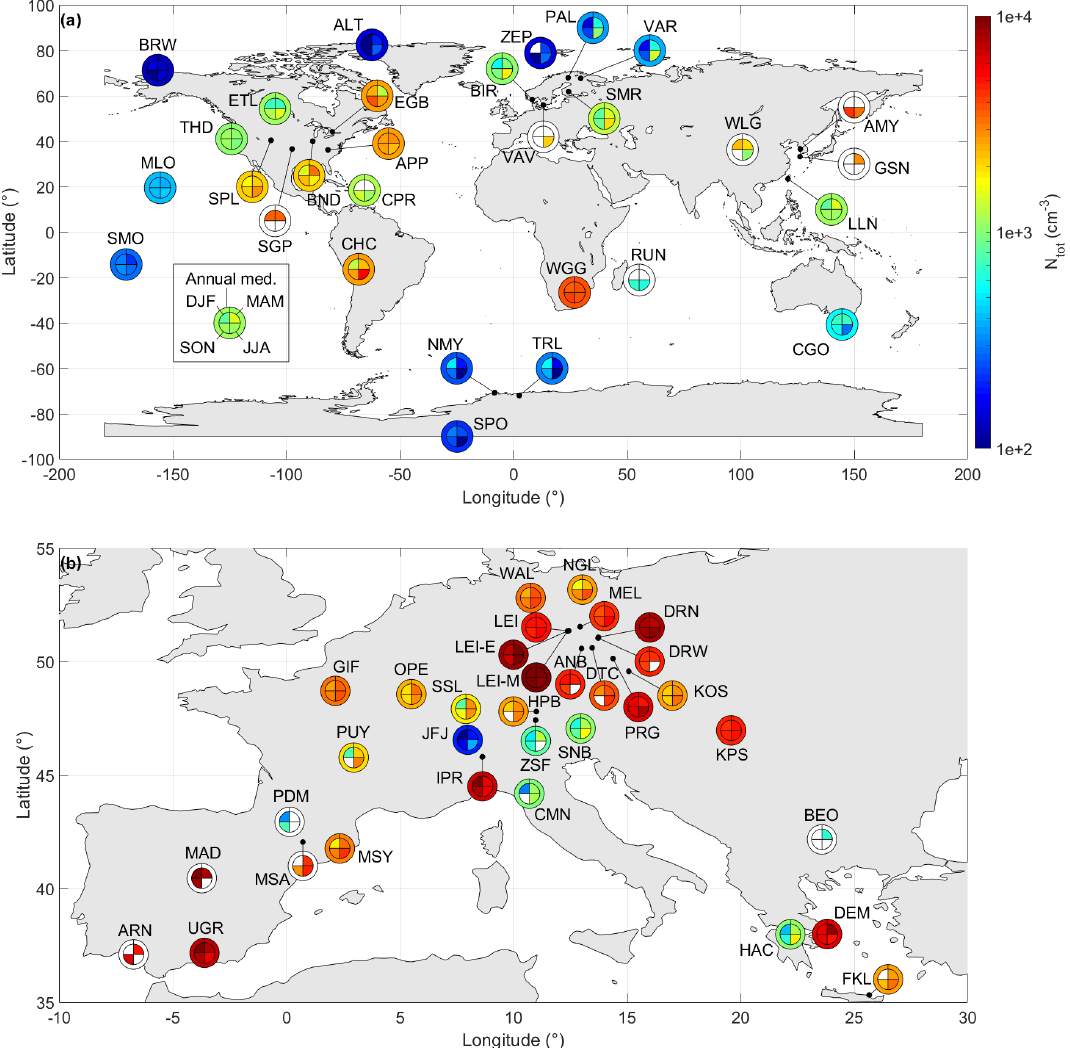
Figure 5. Geographical distribution of N tot (a) at the global scale and (b) specifically over Europe. As indicated in the legend, for each station, seasonal medians are shown in the inner part of the corresponding pie chart and the annual median is represented by the outer ring. The symbols are left empty when data availability was not sufficient over the corresponding